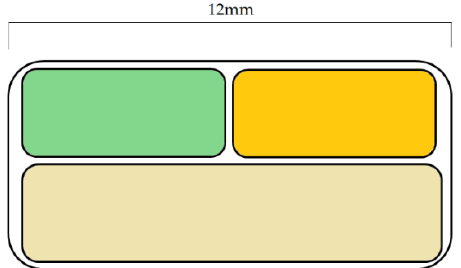
Figure 3. Cross-section of the printed polypills where three diverse compartments were created (labeled with three nonidentical colors) [36].